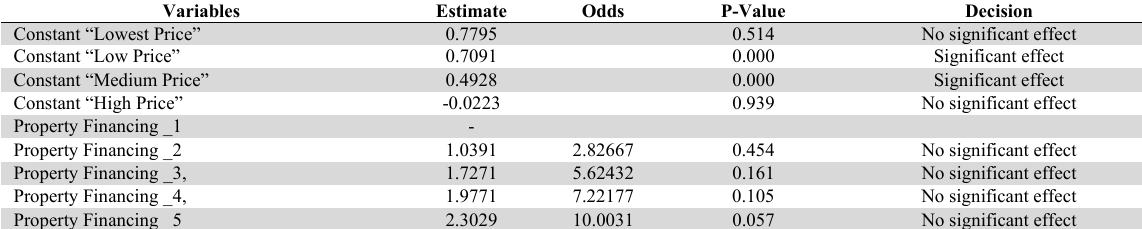
Multiple Ordinal Regression Analysis